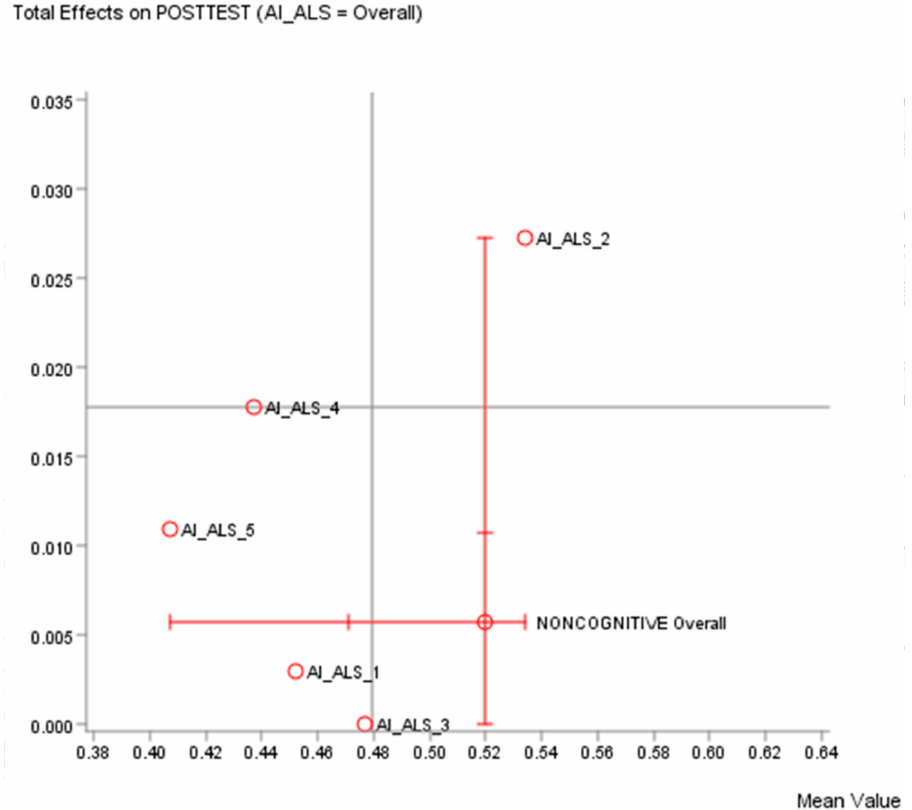
Figure 6. Comparison of Total E ff ects of the data in the Noncognitive node on the Post-test node, which was machine-learned from the data of the five di ff erent groups of students who had used five dissimilar